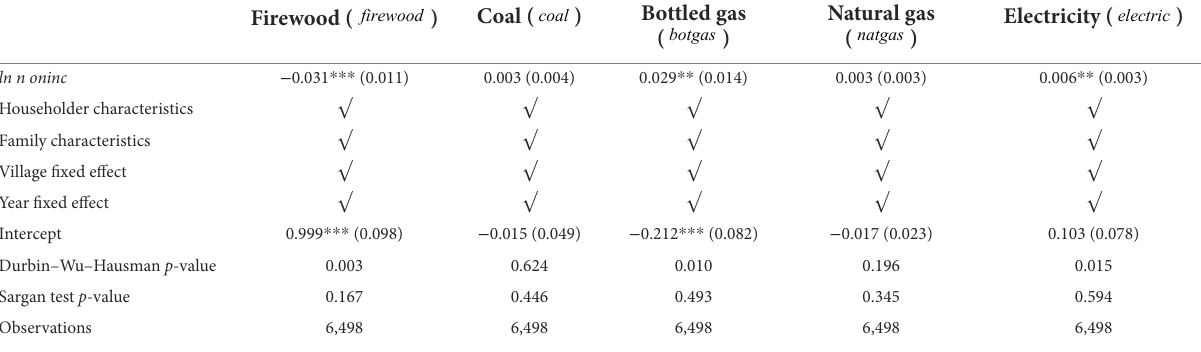
TABLE 7 Robustness test: 2014 sample estimated results.